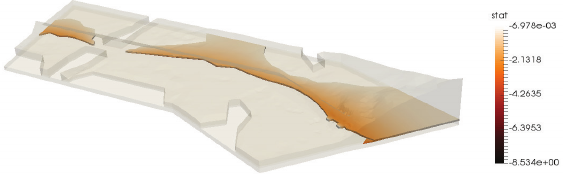
Figure 9: Vector field of seepage speed in the roof of the gravel layer underneath the clay layer after: a) during the period between floods (1 year after flood), b) 15th day of filling. Water table height in gravel layer is shown in the background.